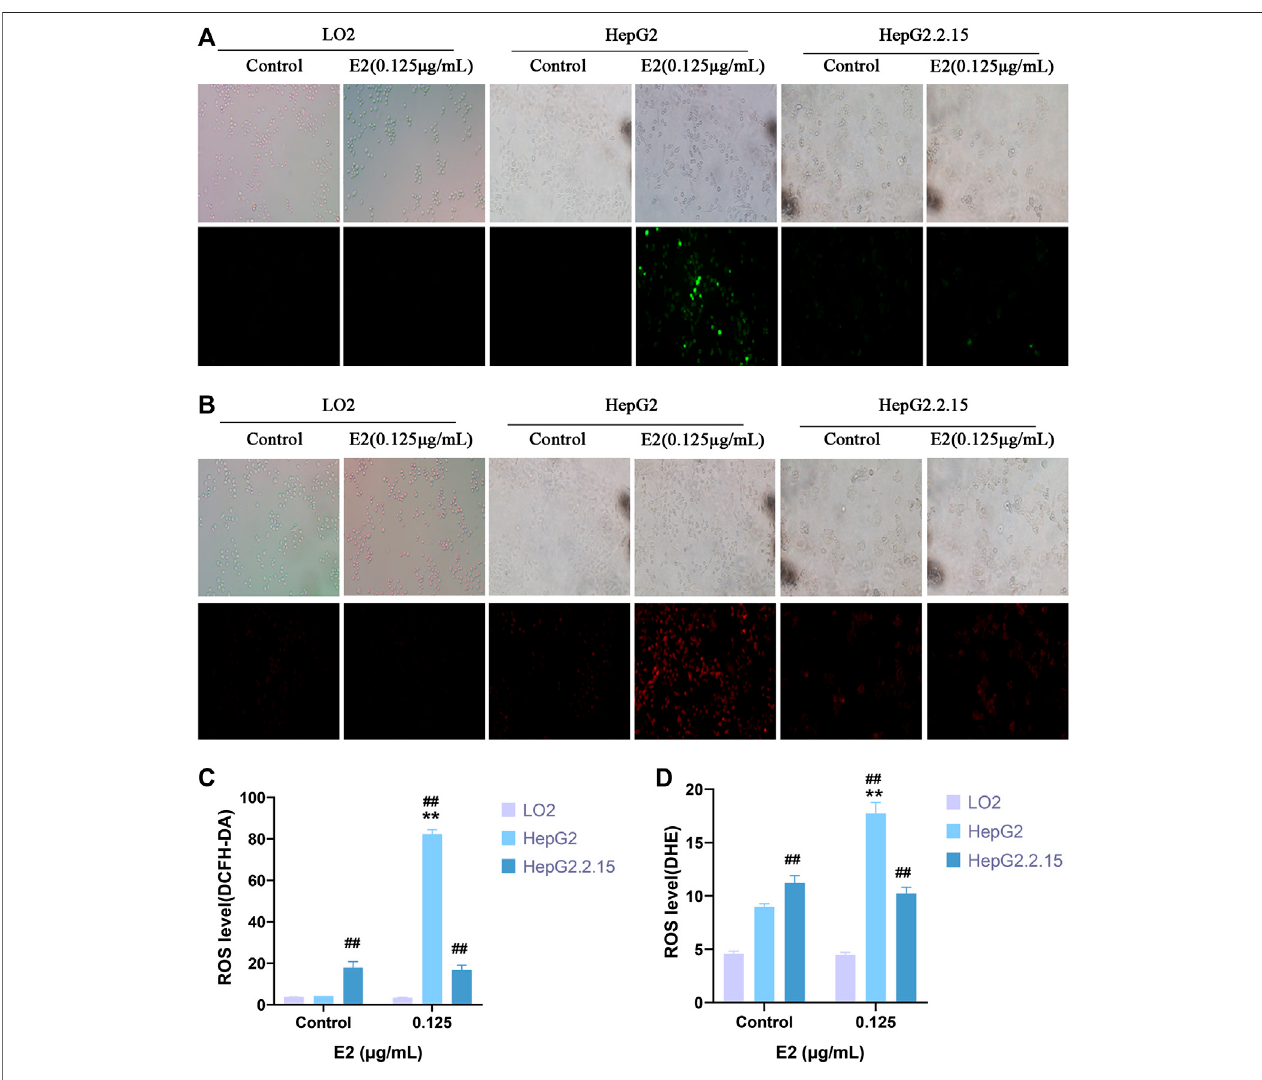
FIGURE 4 | ROS levels in cells as evaluated by immuno fl uorescence staining. (A,C) DCFH-DA. (B,D) DHE. Fluorescence microscopy was used to observe and record fl uorescence levels. ** p < 0.01 compared to the control group, ## p < 0.01 compared to LO2 cells at the same dose.